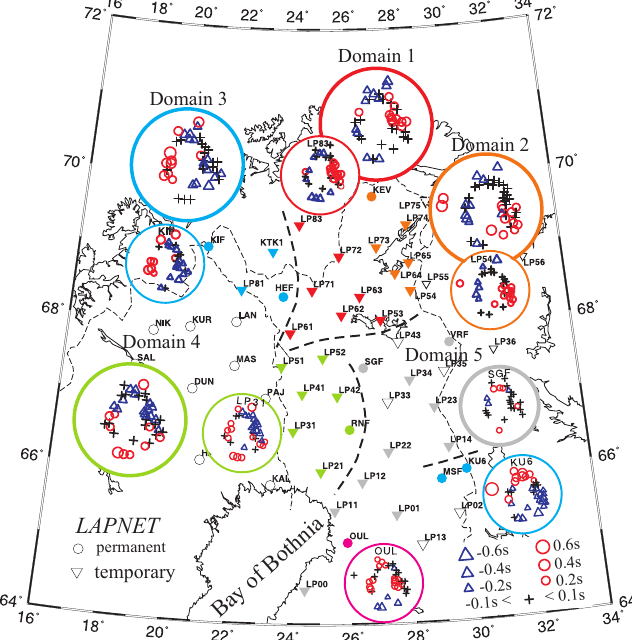
Fig. 2. Stations clustered into domains according to similarity of distribution of early and delayed travel times relative to a directional mean at each station, calculated from relative residuals corrected for crustal effects. The P spheres show smoothed azimuth-incidence angle dependent terms for representatives of each group and those calculated from all stations included in each group (marked by different colours). Thick dashed lines mark schematically the domain boundaries.